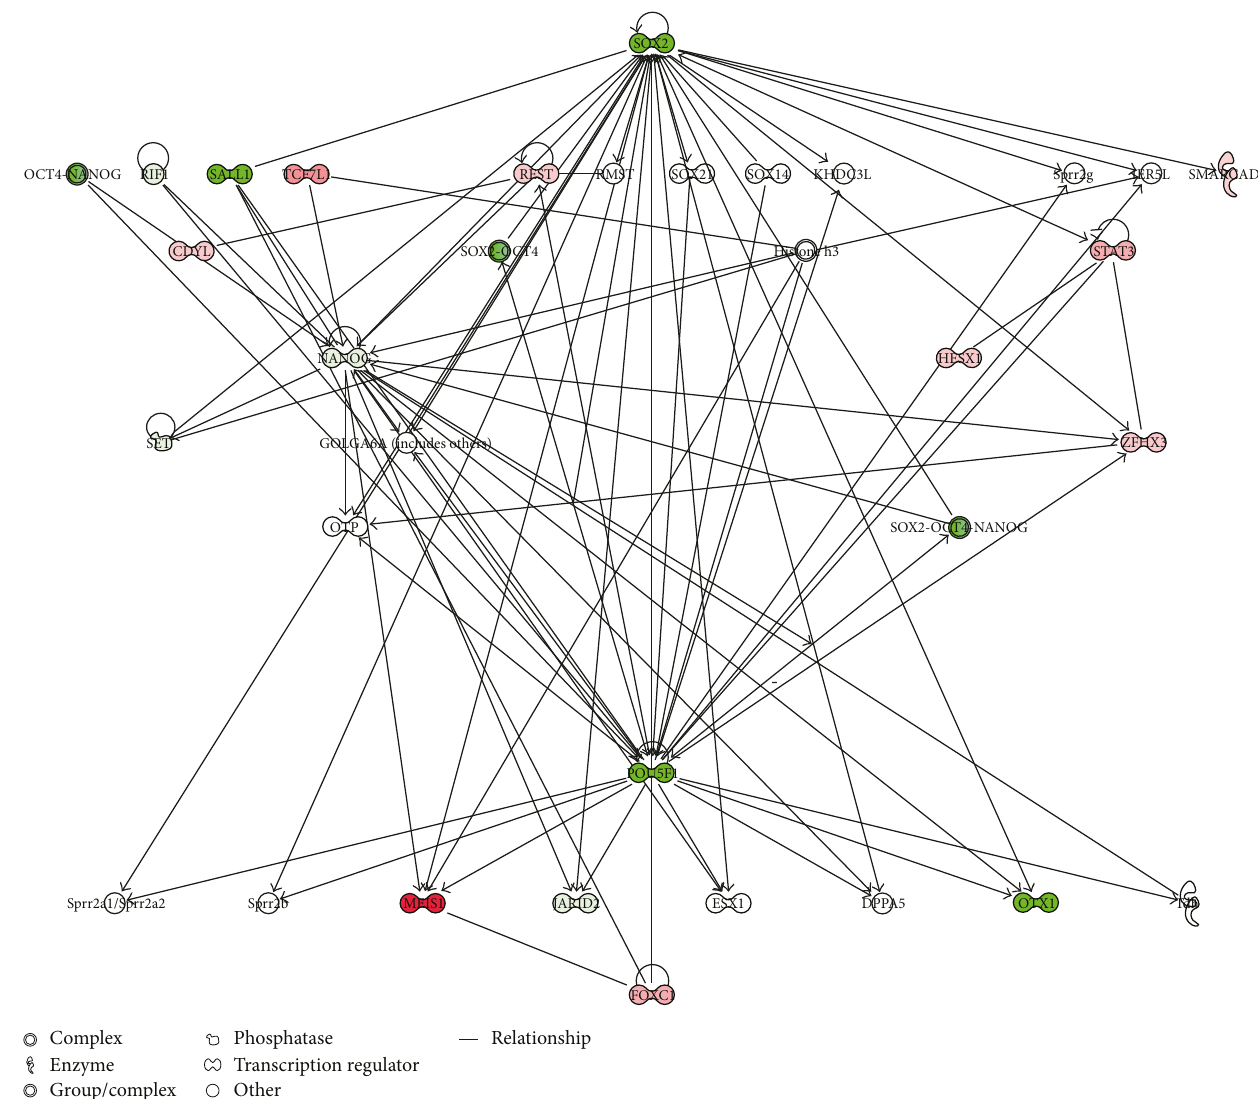
Figure 7: Gene modulation of hDPLSCs. IPA-inferred cluster analysis of the hPDLSC dataset of signi fi cantly expressed genes at